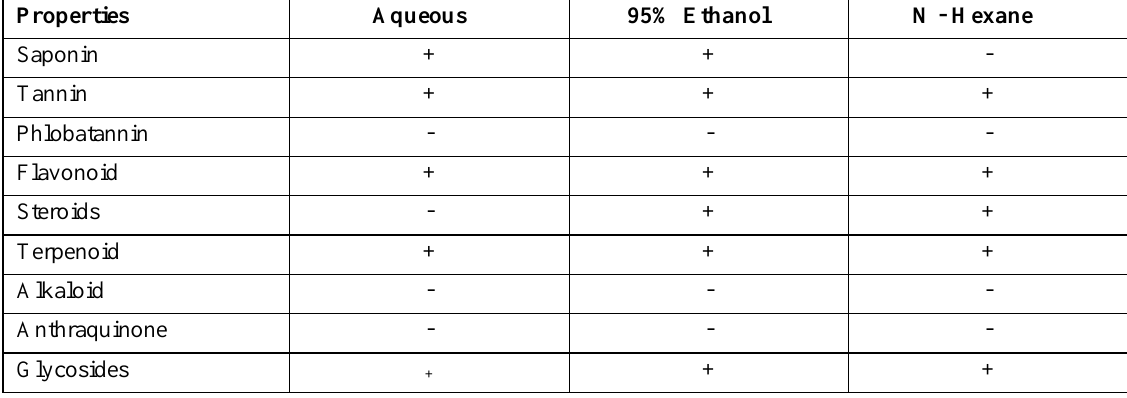
Table 2. Qualitative phytochemical profile of the leaf extracts of C itrus aurantium . Properties